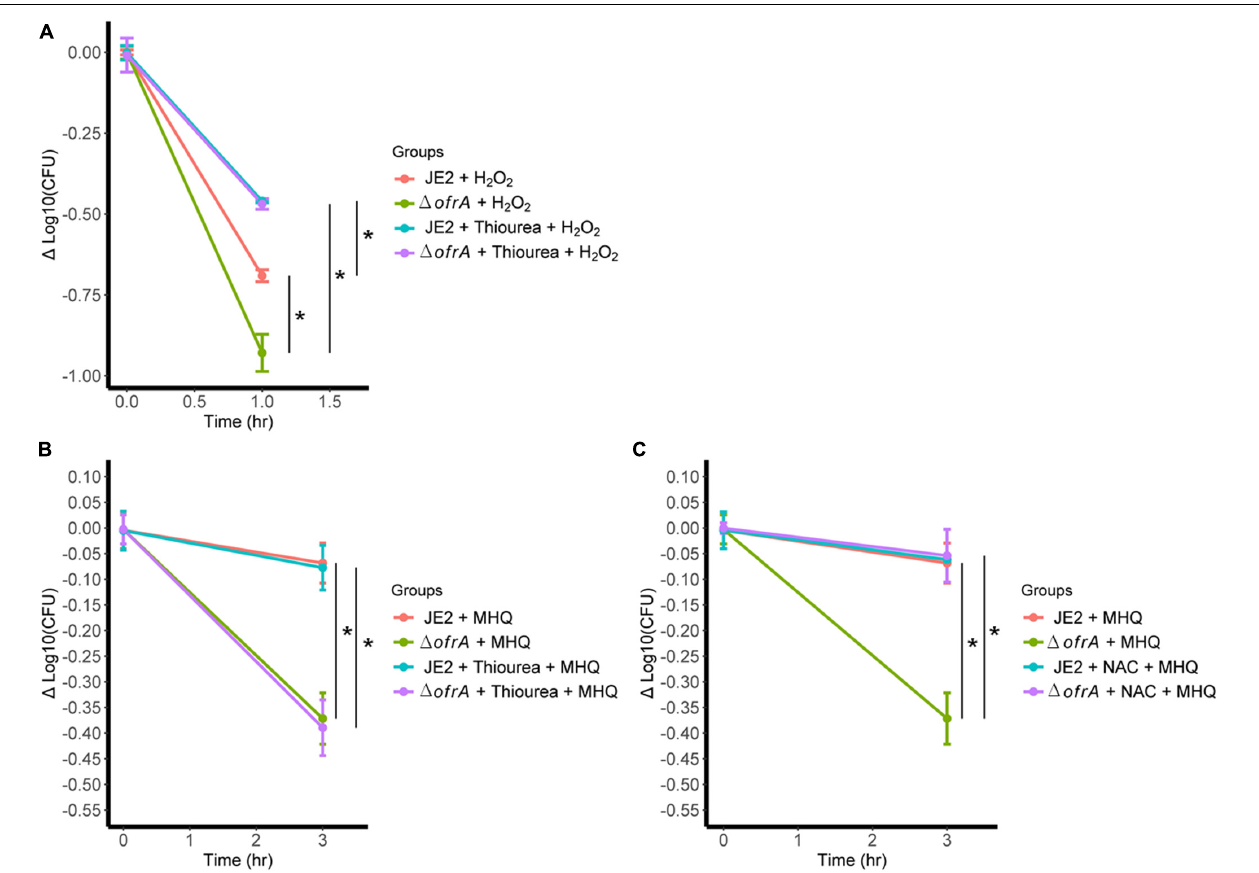
FIGURE 6 | ofrA mutation increases ROS-mediated killing via disturbing thiol-dependent redox homeostasis. (A) Bacterial survival assay in 40 mM H 2 O 2 with or without 120 mM thiourea. The strains were grown in overnight culture in RPMI medium. We diluted the overnight cultures 1:100 in fresh RPMI until mid-logarithmic phase. Cells were harvested by centrifugation and washed with sterile PBS. OD 600 were adjusted to 0.4. Bacteria were challenged with H 2 O 2 with or without 120 mM thiourea. Bacterial survival assay in 0.5 mM MHQ with or without 120 mM thiourea (B) or 1.25 mM NAC (C) . Data represent four biological replicates. Error bars represent the standard error of the means. Statistical analysis was carried out using one-way ANOVA and pairwise t -test with Bonferroni p -value adjustment; * p < 0.05. MHQ, methylhydroquinone; NAC, N -acetyl